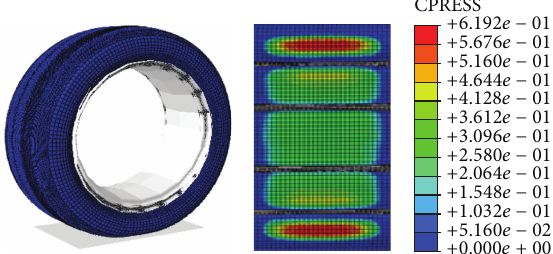
Figure 1: Tire footprint and contact deformation of tire under standard